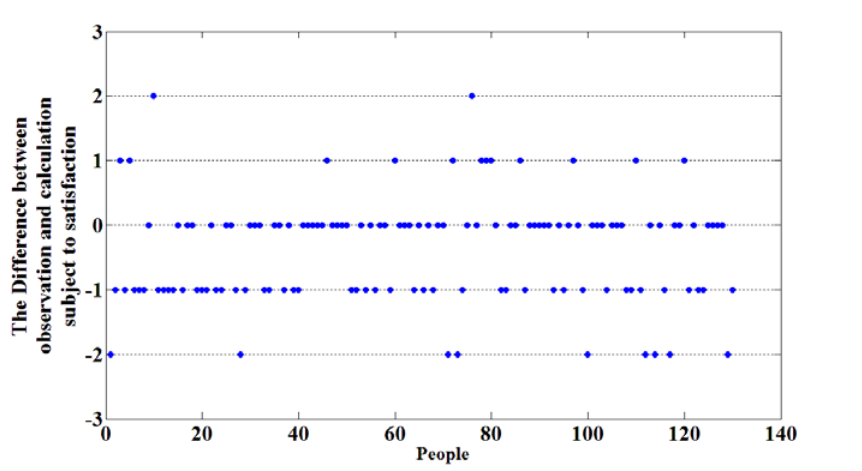
Fig. 2. The summary of calculated versus observed job satisfaction by new